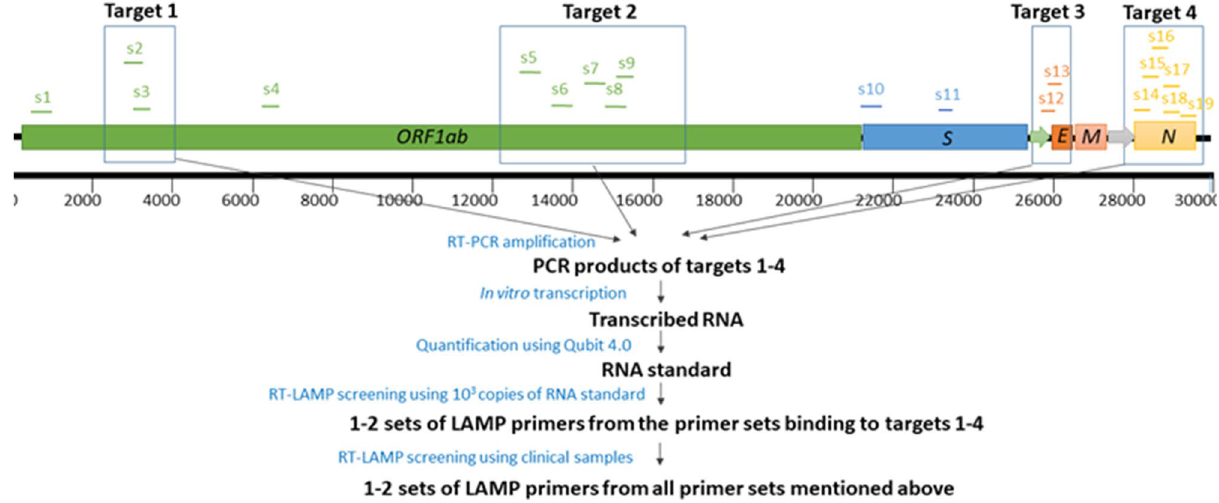
Figure 1. Genome location and evaluation strategy of 19 sets of SARS-CoV-2 RT-LAMP primers. The location of each primer set was detailed in Table